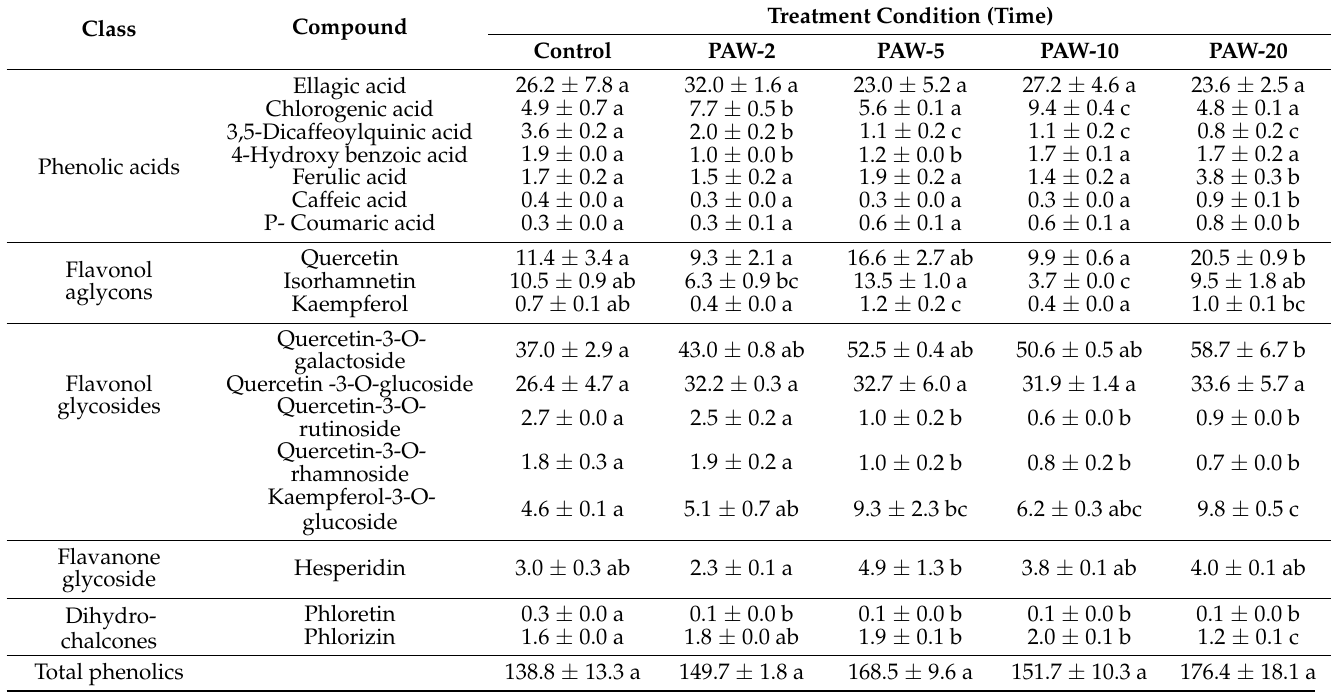
Figure 1. HPLC-MS/MS chromatogram of a standard mixture of 29 phenolic compounds plotted as overlapped “dynamic - Multiple Reaction Monitoring” (MRM) transition of each analyte. (1) Gallic acid, (2) Neochlorogenic acid, (3) (+)-Catechin, (4) Procyanidin B2, (5) Chlorogenic acid, (6) p -Hydroxybenzoic acid, (7) ( − )-Epicatechin, (8) 3-Hydroxybenzoic acid, (9) Caffeic acid, (10) Vanillic acid, (11) Syringic acid, (12) Procyanidin A2, (13) P Coumaric acid, (14) Ferulic acid, (15) 3,5-Dicaffeoylquinic acid, (16) Rutin, (17) Hyperoside, (18) Isoquercitrin, (19) Phloridzin, (20) Quercitrin, (21) Myricetin, (22) Naringin, (23) Kaempferol-3-glucoside, (24) Hesperidin, (25) Ellagic acid, (26) Quercetin, (27) Phloretin, (28) Kaempferol, (29) Isorhamnetin. Table 2. Content of phenolic compounds (mg kg − 1 , D.W.) determined by HPLC-MS/MS in control and PAW treated rocket samples processed at different times.